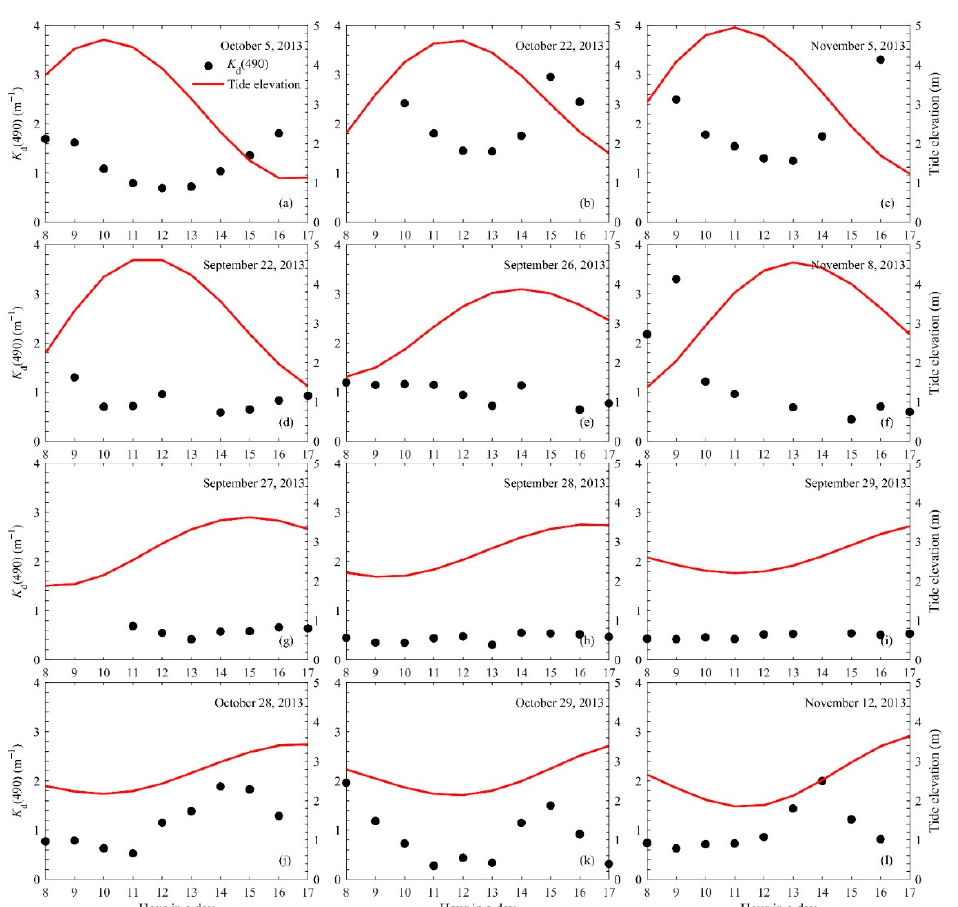
Figure 9. Diurnal variation of K d ( 490 ) and tide elevation for the 12 days from 08:00 to 17:00 BJT: ( a ) 5 October, 2013; ( b ) 22 October, 2013; ( c ) 5 November, 2013; ( d ) 22 September, 2013; ( e ) 26 September, 2013; ( f ) 8 November, 2013; ( g ) 27 September, 2013; ( h ) 28 September, 2013; ( i ) 29 September, 2013; ( j ) 28 October, 2013; ( k ) 29 October, 2013; ( l ) 29 November, 2013.